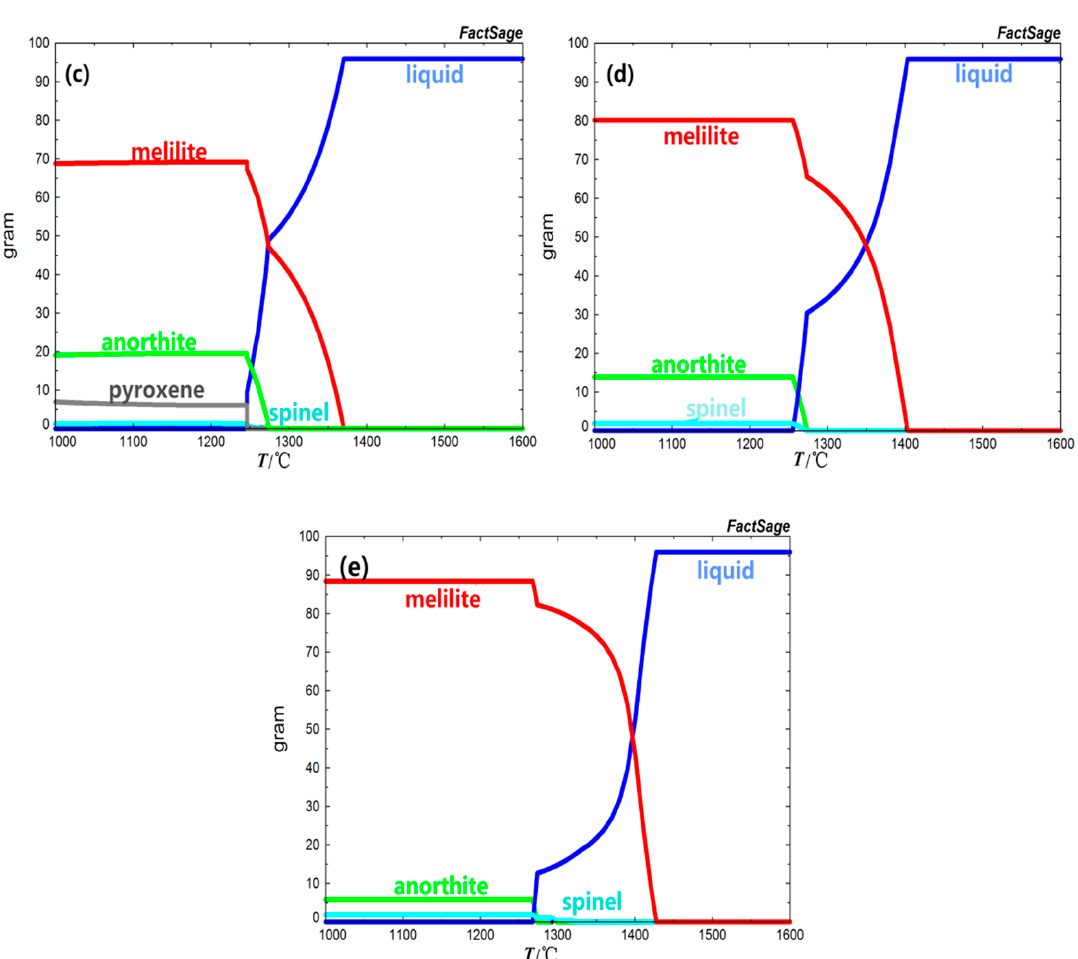
Figure 1. Mineral crystallization diagram of the BFS with different basicities. ( a ) R = 0.7; ( b ) R = 0.8; ( c ) R = 0.9; ( d ) R = 1.0; ( e ) R = 1.1.